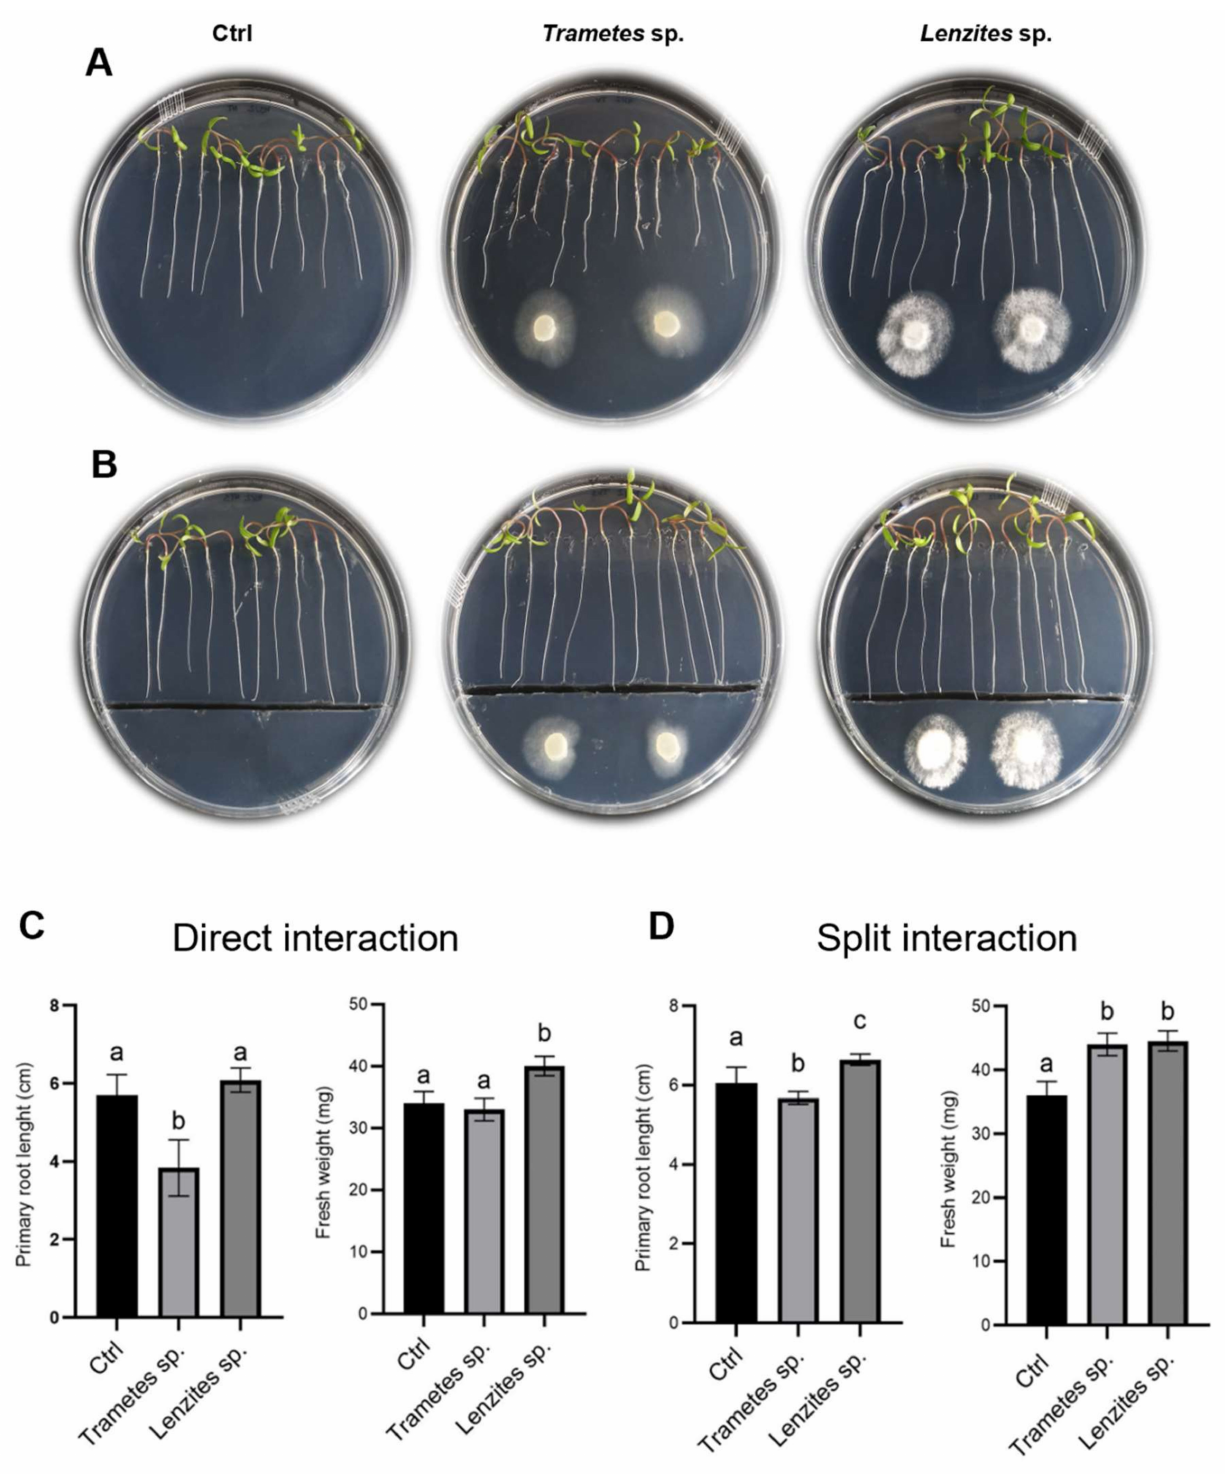
Figure 6. Effect of Trametes sp. S2.OA.C_F6 and Lenzites sp. S3.OA.B_F6 isolates on tomato growth. ( A , B ) Representative photos of 8-day-old tomato plantlets grown on MS 1 / 2 medium at 3 dpi. ( A ) Direct interaction experiments and ( B ) split interaction experiments. ( C , D ) Physiological parame- ter measurements. Primary root length (cm) and fresh weight (mg) measured in direct interaction experiments ( C ) and split interaction experiments ( D ). Bar plots represent mean ± SD ( n = 15). Different letters indicate significant differences (one-way ANOVA, p < 0.05; Tukey post hoc test, p <